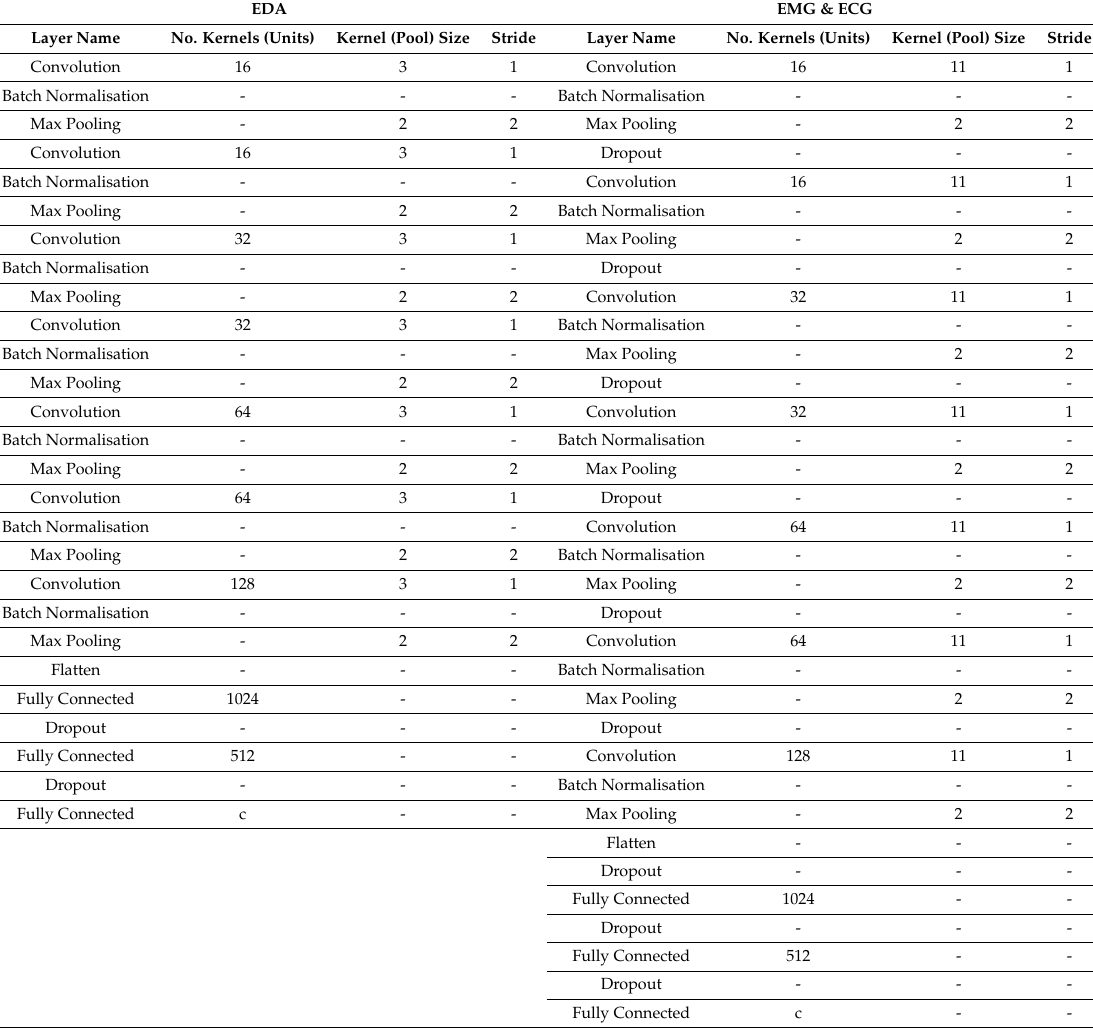
Table 1. Deep classification architectures for each of the recorded physiological